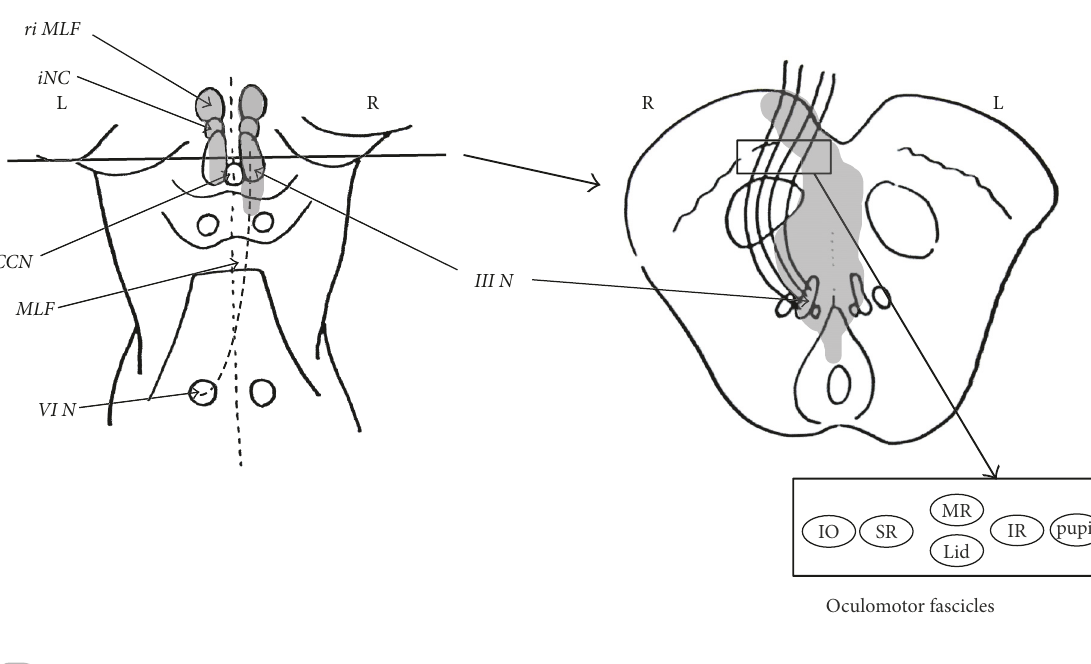
Figure 6: Picture in the left shows dorsal side of the midbrain and pons and in the right shows cross-sectional view of the midbrain along the line. Gray areas mark the ischemic area. riMLF: rostral interstitial nucleus of medial longitudinal fasciculus, iNC: interstitial nucleus of Cajal, CCN: caudal central subnucleus, MLF: medial longitudinal fasciculus, III N: oculomotor nucleus, VI N: abducens nucleus, IO: intraocular muscles, SR: superior rectus muscle, MR: medial rectus muscle, Lid: Levator palpebrae superioris muscle, IR: inferior rectus muscle, and pupil: sphincter pupillae